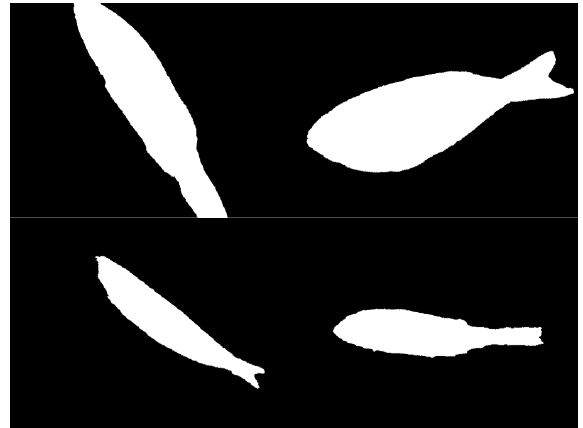
Figure 15. The segmentation results of